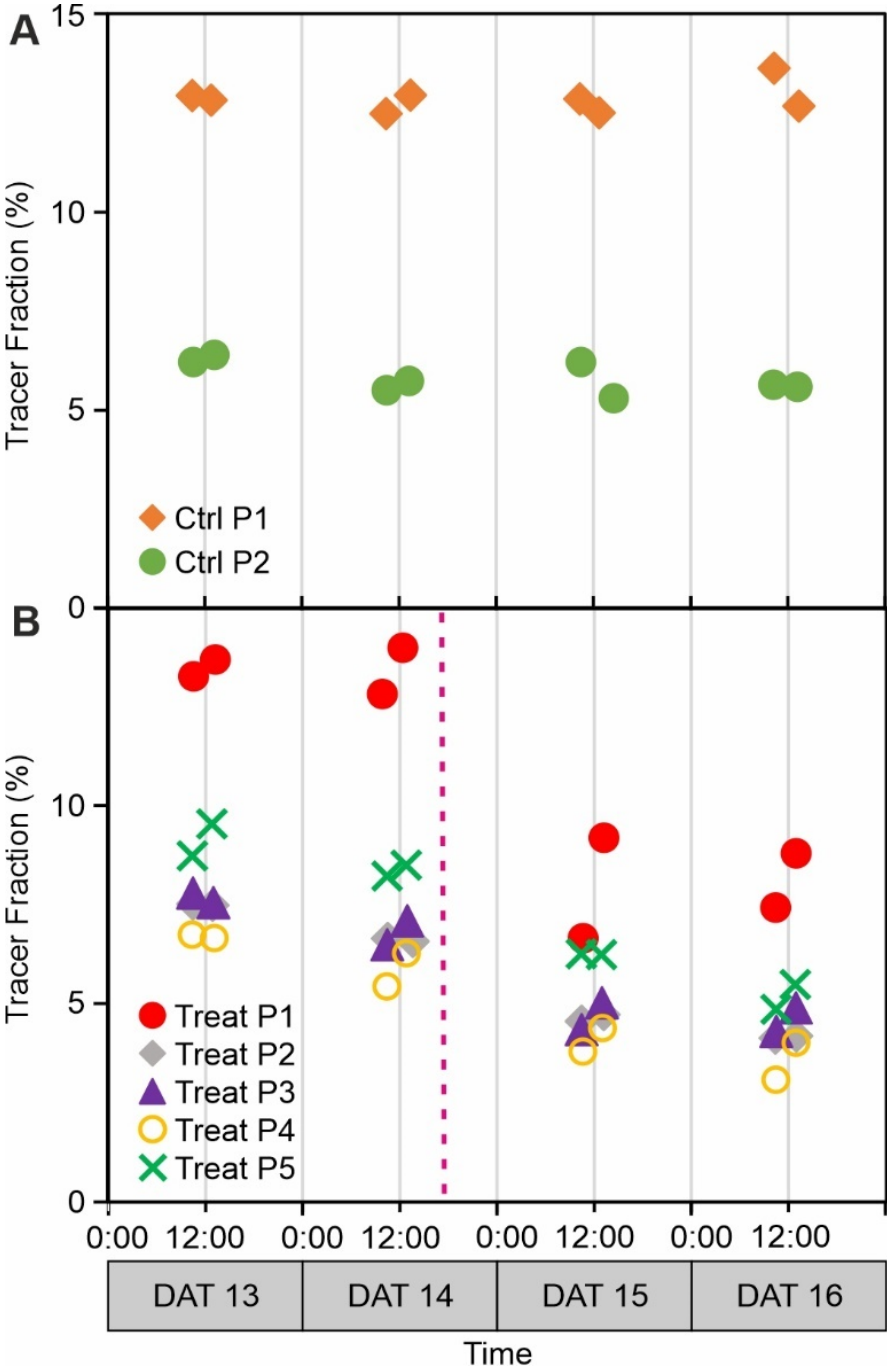
Figure 5. Carbon tracer allocation to nodules as fractions of the total tracer allocated to the root system detected by PET. ( A ) Two control plants (Ctrl P1 and P2). ( B ) Five plants treated with nitrate (Treat P1-5) in the root zone. Fractions for all six nodule ROIs per plant and labelling experiment were summed up to one data point. Standard deviation (SD) was lower than marker size. Individual ROI values for control Plant 1 are displayed in Figure 4, individual ROI values of the other plants can be found in Figure S2. The starting time of the treatment is indicated by a dotted magenta line in ( B ). DAT, days after transfer to pot.